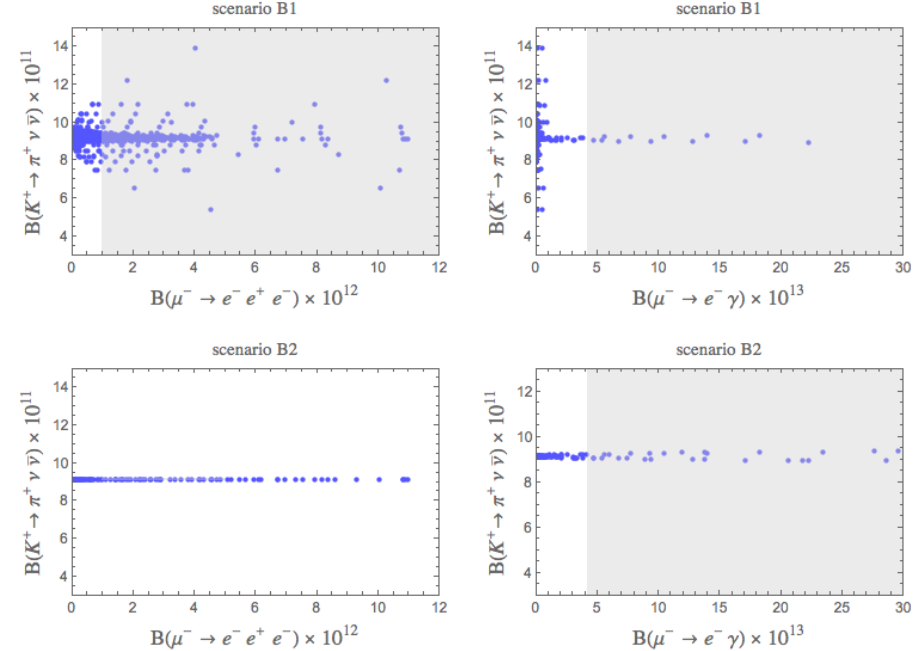
Figure 11 . Scenarios B1 (upper plots) and B2 (lower plots). Correlation between B ( K + ! (cid:25) + (cid:23) (cid:22) (cid:23) ) and B ( (cid:22) (cid:0) ! e (cid:0) e + e (cid:0) ) (left panels) and between B ( K + ! (cid:25) + (cid:23) (cid:22) (cid:23) ) and B ( (cid:22) (cid:0) ! e (cid:0) (cid:13) ) (right panels). The gray shaded regions are excluded by the experimental bounds B ( (cid:22) (cid:0) ! e (cid:0) e + e (cid:0) ) < 1 (cid:1) 10 (cid:0) 12 and B ( (cid:22) (cid:0) ! e (cid:0) (cid:13) ) < 4 : 2 (cid:1) 10 (cid:0) 13 .